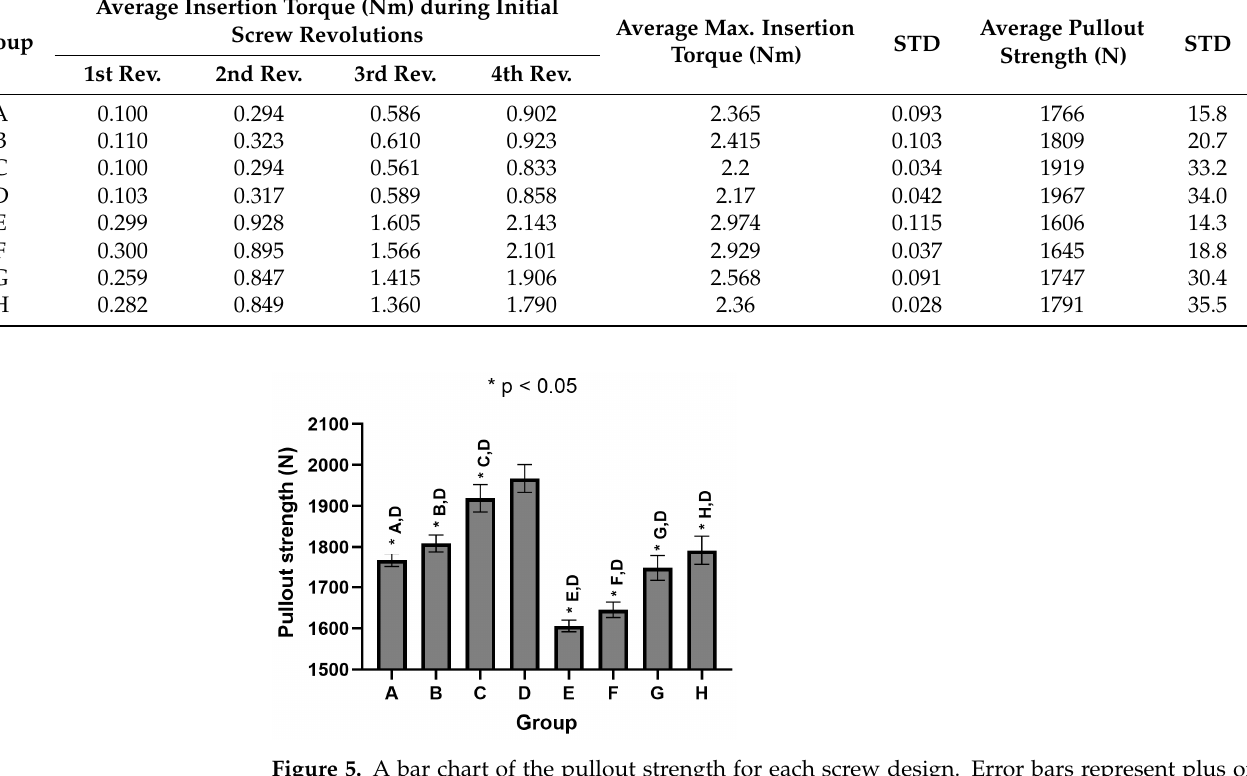
Table 2. Mean results of insertion torque and pullout strength in each group.